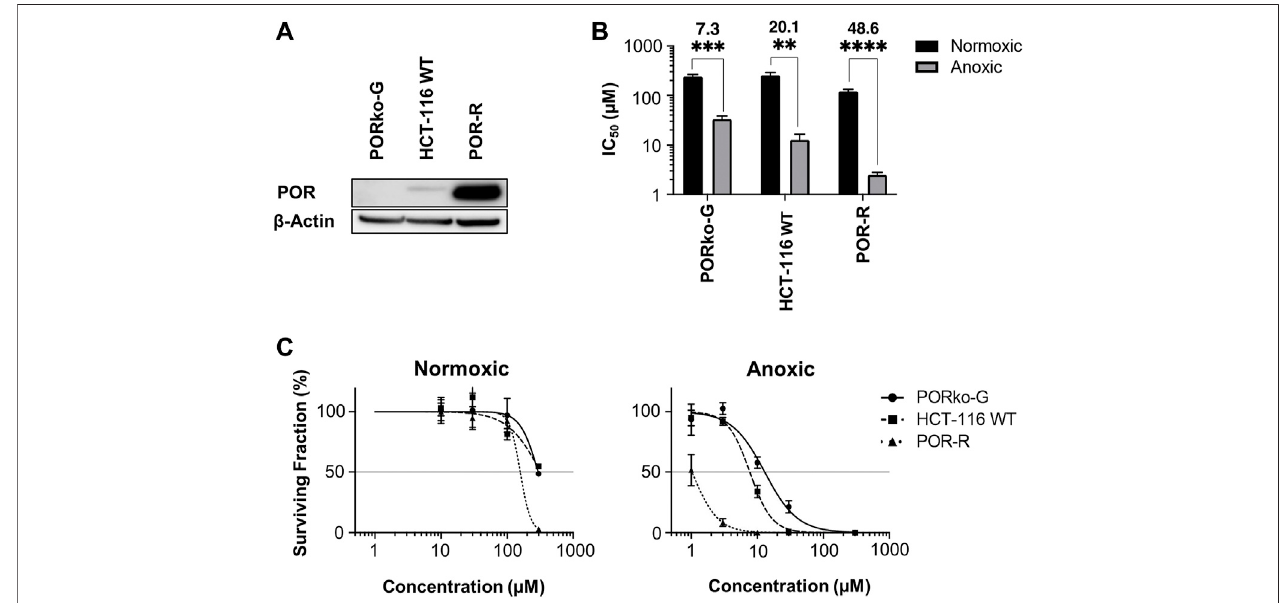
FIGURE 1 | Hypoxia-dependent cellular cytotoxicity of CP-506 is in fl uenced by POR expression. (A) Western blot analysis of POR expression in HCT-116 cells upon gene knockout (PORko-G) and ectopic overexpression (POR-R) as compared to the parental cell line (HCT-116 WT). (B) Anti-proliferative potency after exposure ofmonolayer cultures(700 – 1000cellsperwell)toCP-506for4 hundernormoxic(21%O 2 )and anoxicconditions( < 1 ppmO 2 ).IC 50 valuesweredetermined after 96 h of drug-free proliferation asthedrug concentrationrequired toinhibit cellular proliferation by50% oftheuntreated controls. Values are themean ± SEM oftriplicate wells for three independent experiments. ANOVA tests were performed using GraphPad Prism 8 ( p -value ≤ 0.01; ***, p -value ≤ 0.001; ****, p -value ≤ 0.0001). (C) Clonogenic survival after exposure of monolayer cultures (4.8 x 10 5 cells per well) to CP-506 for 4 h under normoxic (21% O 2 ) and anoxic conditions ( < 1 ppm O 2 ). IC 50 values were interpolated from the fi tted dose response curve as the concentration required to reduce the clonogenic surviving fraction to 50% of the untreated controls (shown by the reference line). Values are the mean ± SEM of duplicate wells for three independent experiments.